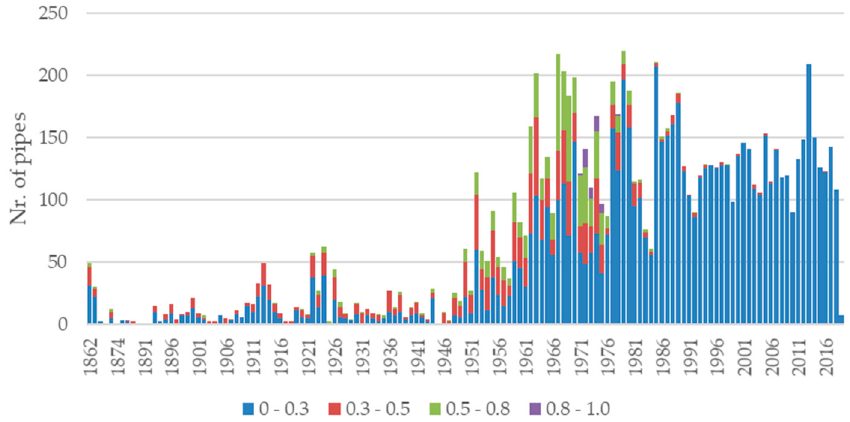
Figure A2. Number of pipes as a function of pipe diameter and installation year.